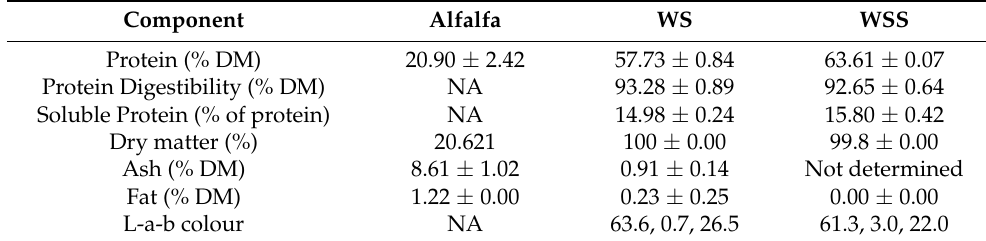
Table 4. Composition of the raw alfalfa, the two types of WAPC (produced from the single screw press-based process), n = 2. Here, WS is not SFE treated; WAPC and WSS are SFE treated WAPC. NA = not analyzed or not